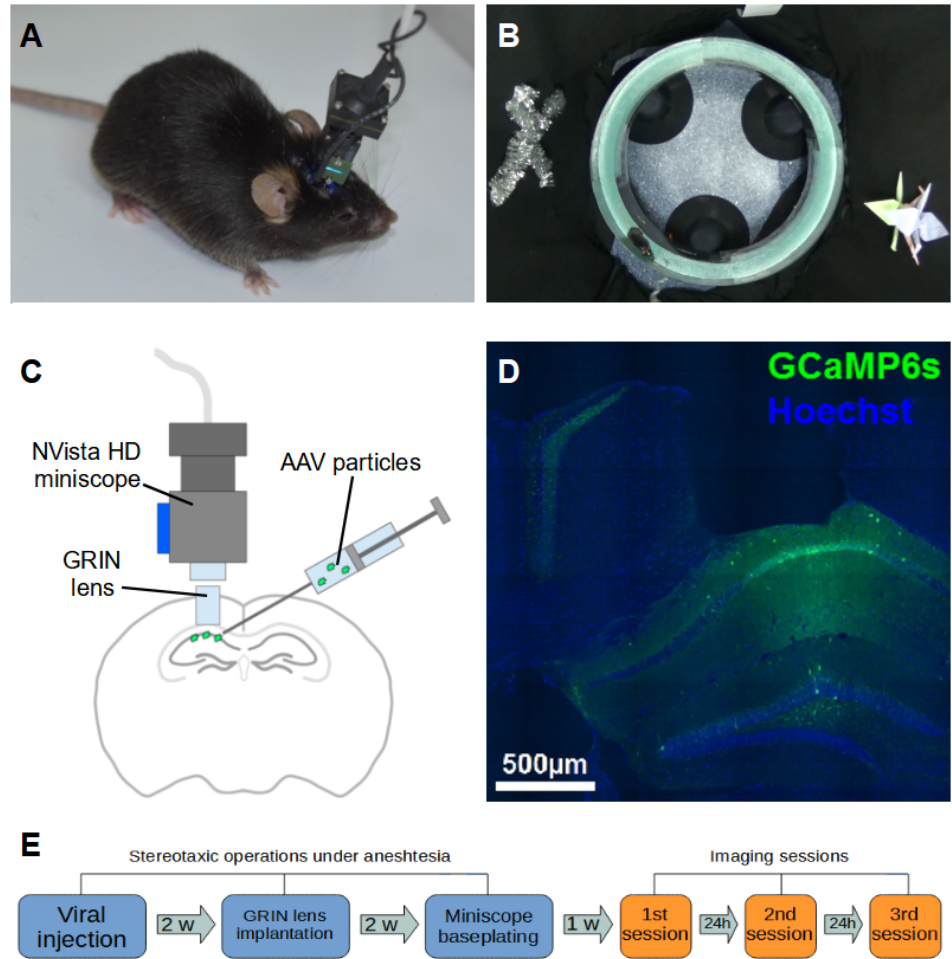
Figure 1. ( A , B ) Mouse with an attached NVista HD miniscope exploring the circular track. ( C ) A scheme of calcium sensor injection and GRIN lens implantation. ( D ) A coronal brain section with a footprint of a GRIN lens and calcium sensor expression. ( E ) The timeline of surgical preparations and